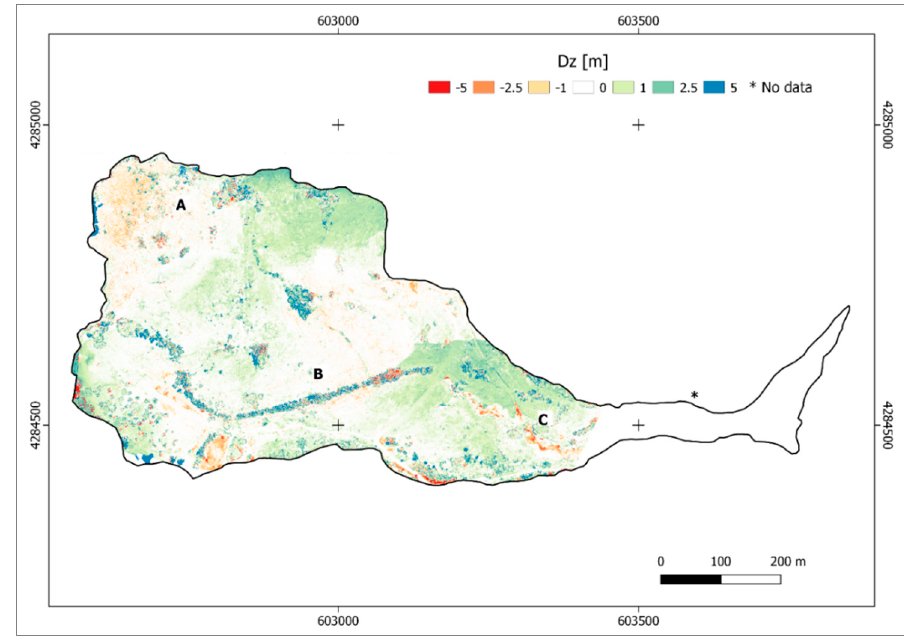
Figure 10. Detail of the 2017–2018 DoD with a customized color scale.